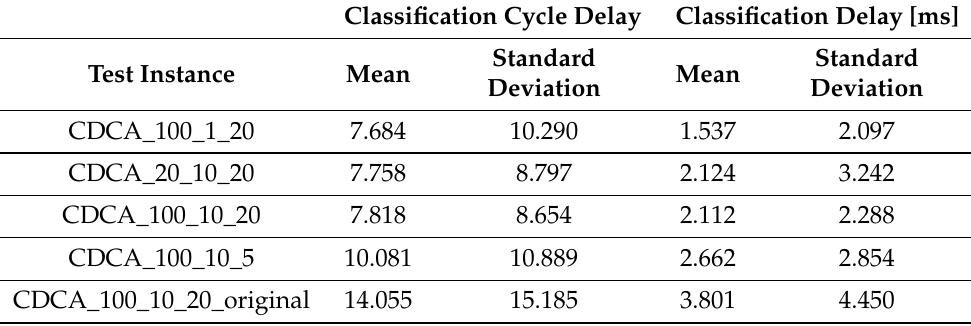
Table 2. Performance results for CDCA with multiple parameters. These results pertain only to outliers and are an average of the results of 10 repeated test